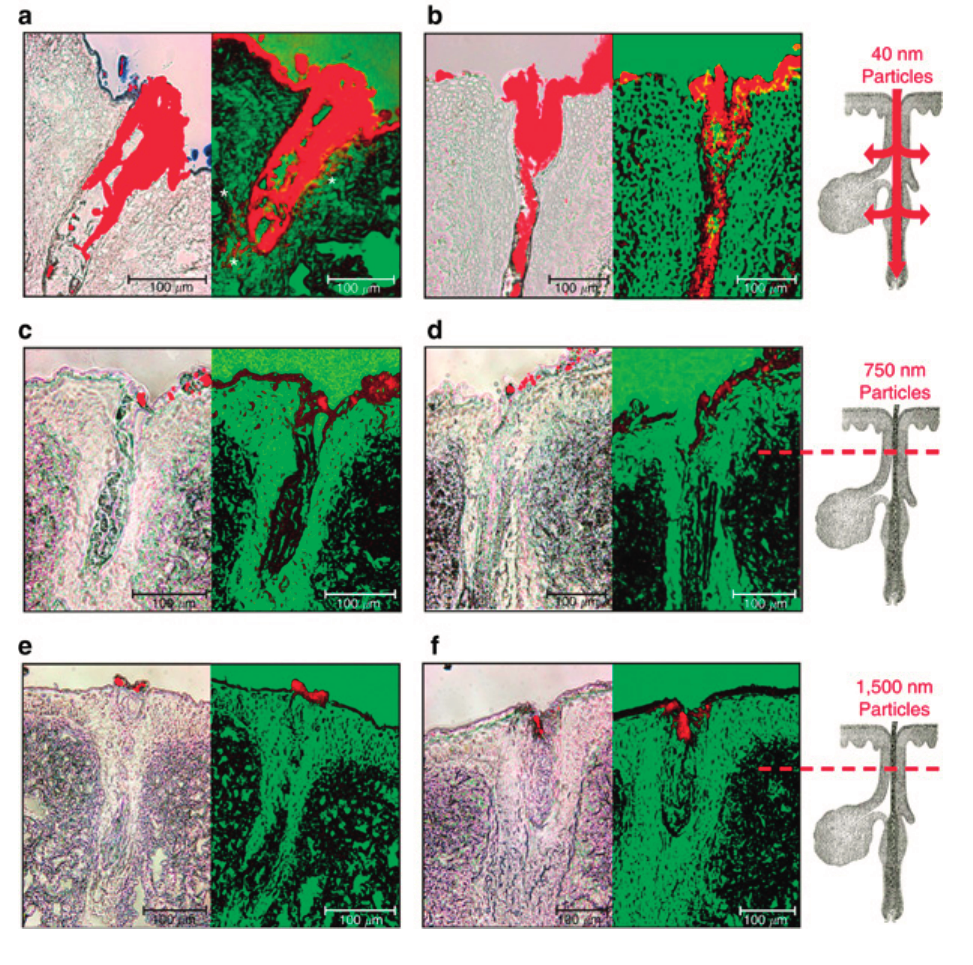
Figure 2. Penetration of variably sized nanoparticles via the hair follicle. Laser scan microscopy was performed on skin samples treated with variably size particles. It was found that 40 nm particles ( a , b ) penetrated deep into hair follicles. In contrast, 750 nm particles ( c , d ) and 1500 nm particles ( b , f ) aggregated in the infundibulum. Reprinted with permission from [15], published by Nature Publishing Group,